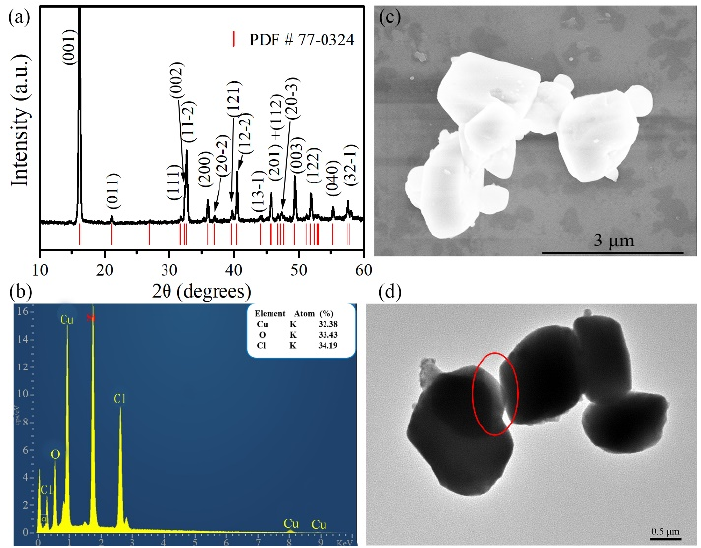
Figure 1. The typical XRD pattern ( a ), the EDX spectra ( b ), the SEM image ( c ), and the TEM image ( d ) of the prepared Cu(OH)Cl sample.